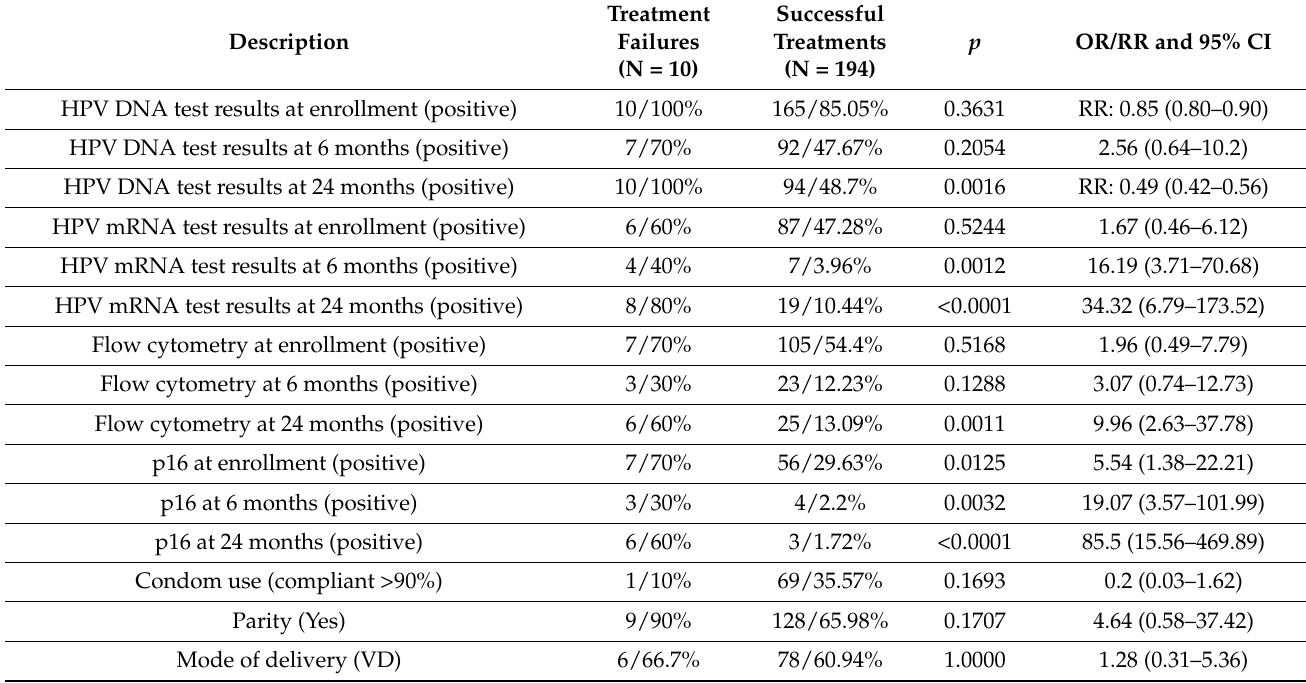
Table 6. Results from statistical comparisons between treatment failures and successful